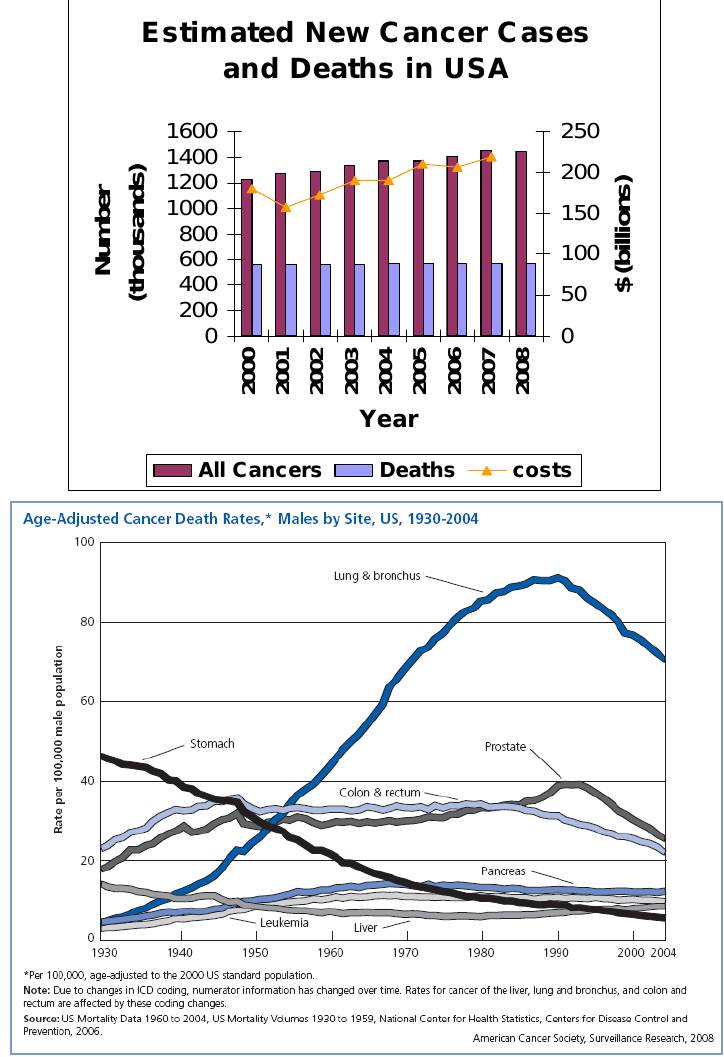
Figure 5. Estimated New Cancer Cases and Deaths in USA [7]. Estimated New Cancer Cases and Deaths in